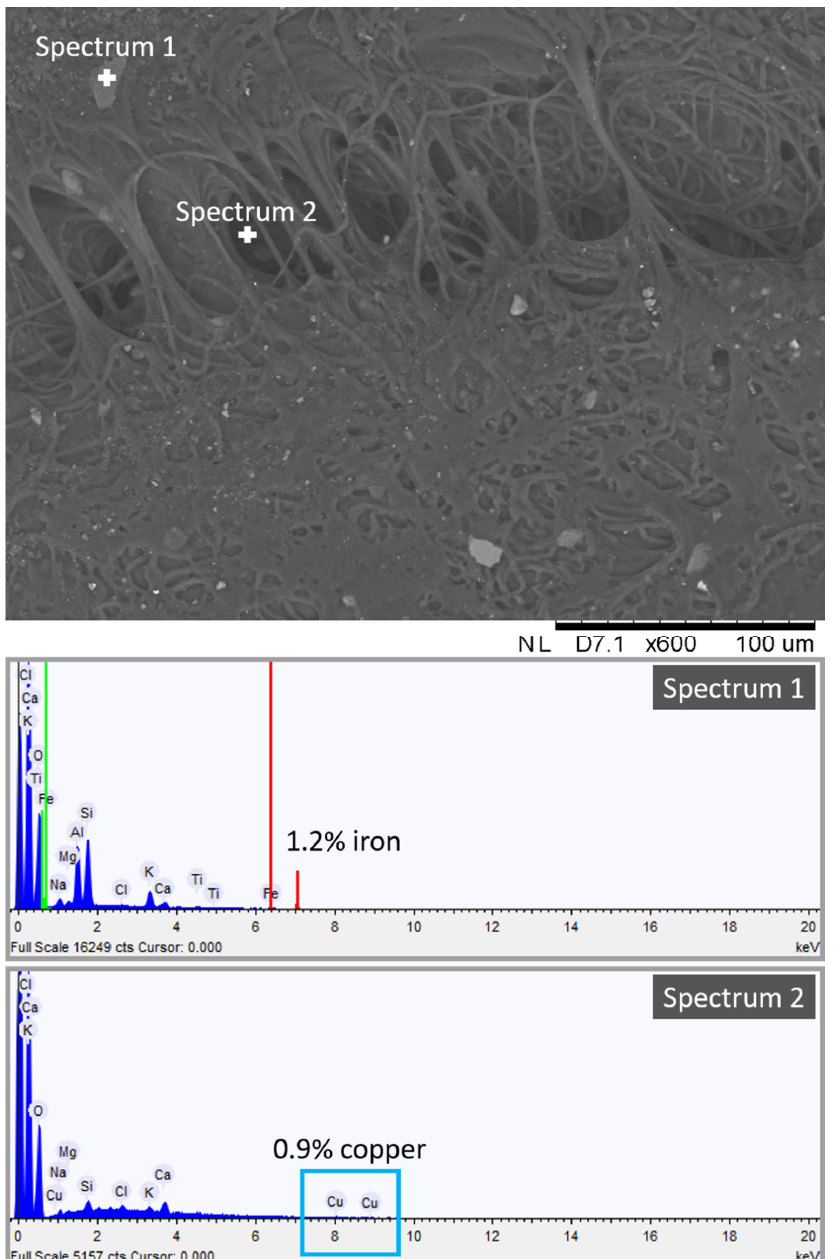
Figure 7. SEM-EDS spectrum and image of the dirty hydrogel layer removed after cleaning of the Travertine surface soiled with acidic corrosion products from penny.